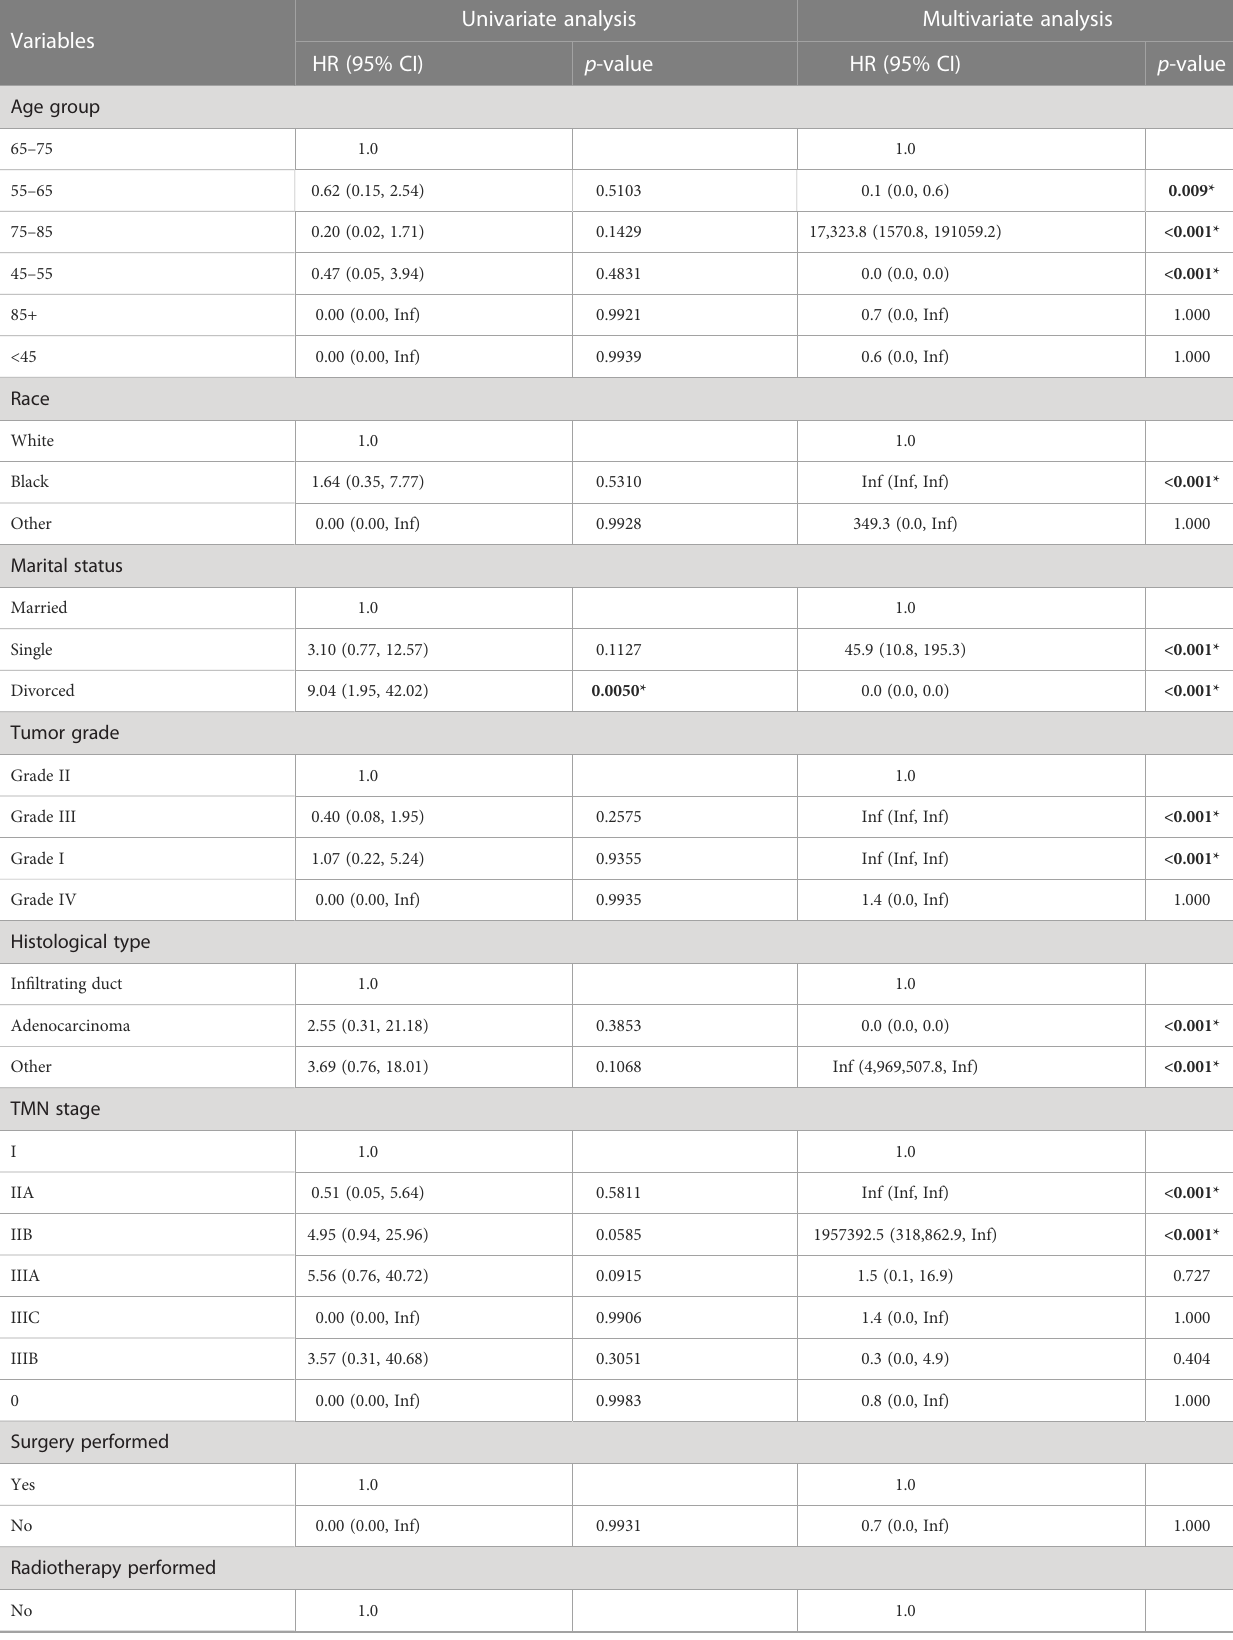
TABLE 4 Univariate and multivariate analysis of the occurrence of